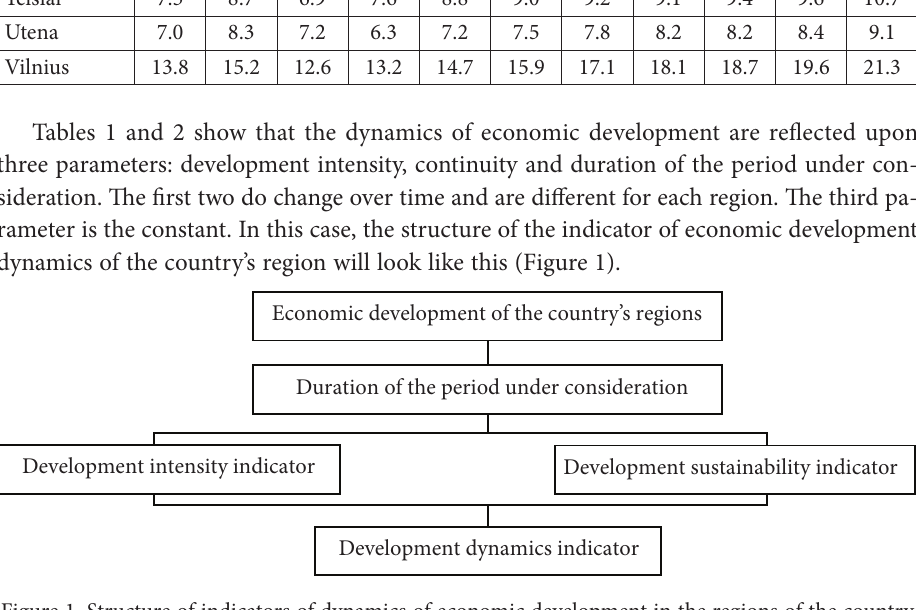
Figure 1. Structure of indicators of dynamics of economic development in the regions of the country (source: based on Ginevičius et al.,